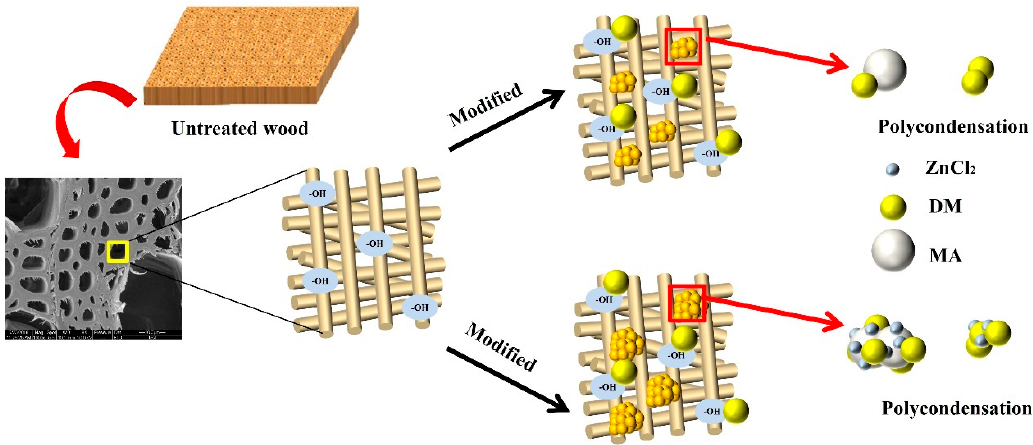
Figure 1. Curing mechanism of ZnCl 2.